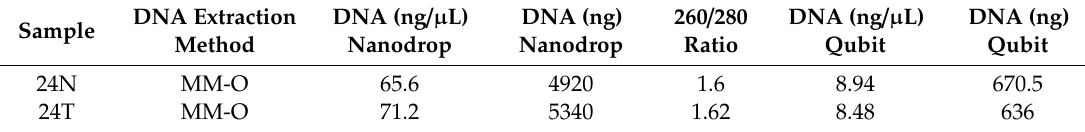
Table 2. Quantification of normal vs. tumor DNA extracted after 24 h, 48 h or 72 h formalin fixation by comparing two automatic recovery systems using Nanodrop and Qubit